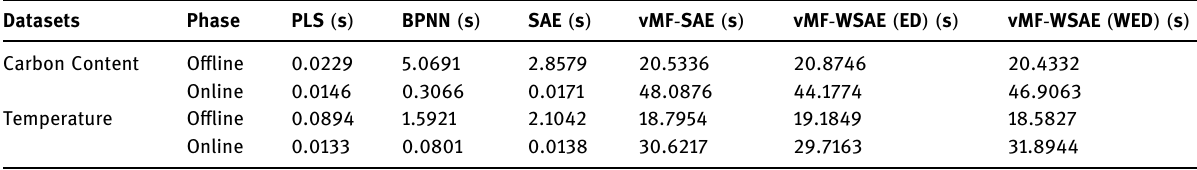
Table 8: Comparison the proposed method with other methods in terms of prediction evaluation indicators Indicators Carbon content regression accuracy